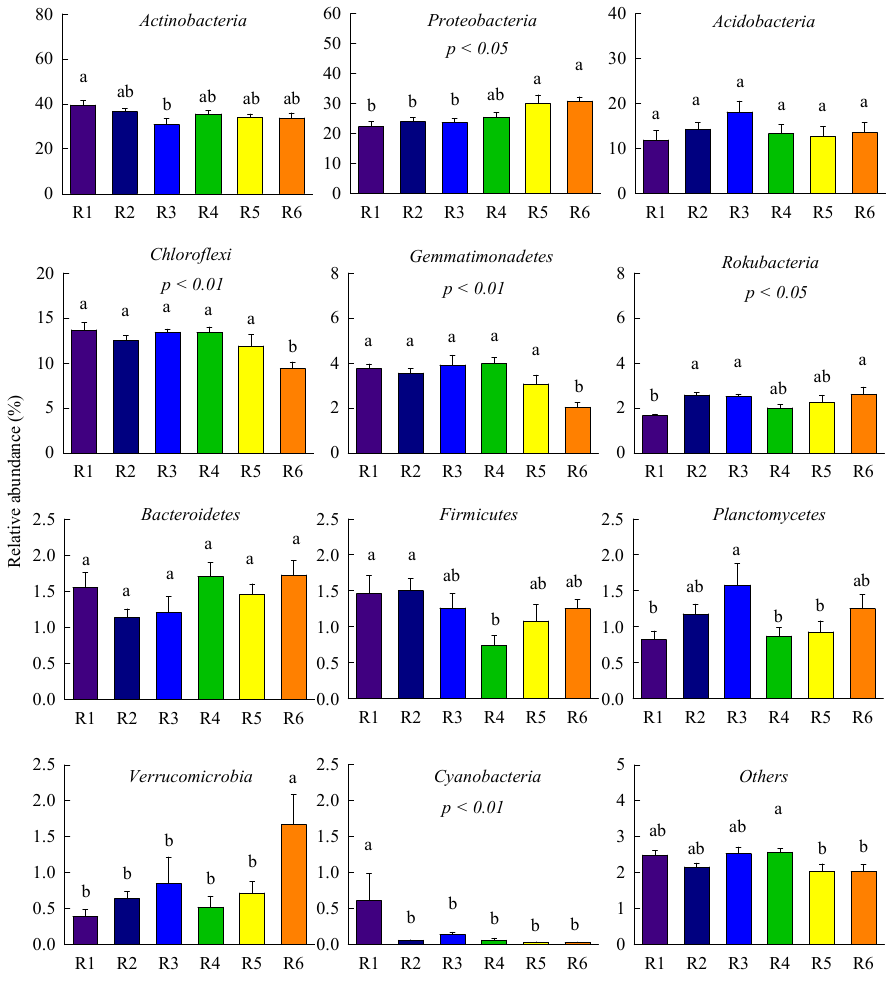
Figure 3. Relative abundance (% of individual taxonomic groups) of the dominant bacterial phyla (mean ± SE, n = 4) present in the microbial communities of different successional stages on the Loess Plateau of China. Different lower-case letters indicate statistically significant differences at the α = 0.05 level between successional stages. See Figure 2 for abbreviations. Table 2. Relative abundance (% of individual taxonomic groups) of the dominant bacterial classes (mean ± SE, n = 4) present in the soil (0–20 cm depth) microbial communities of different successional stages on the Loess Plateau of China.